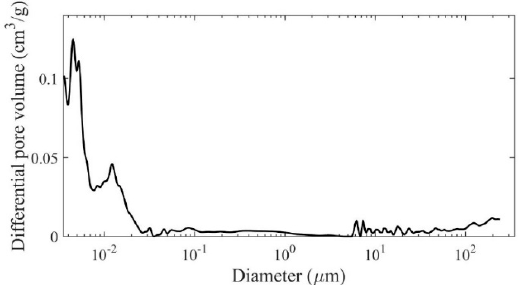
Figure 3. Differential curve of pore volume distribution in the function of the pore diameter in the RPC after 28 days of maturation. Table 4. Total porosity and percentage of pores, depending on the diameter in the RPC after 28 days. Total Porosity